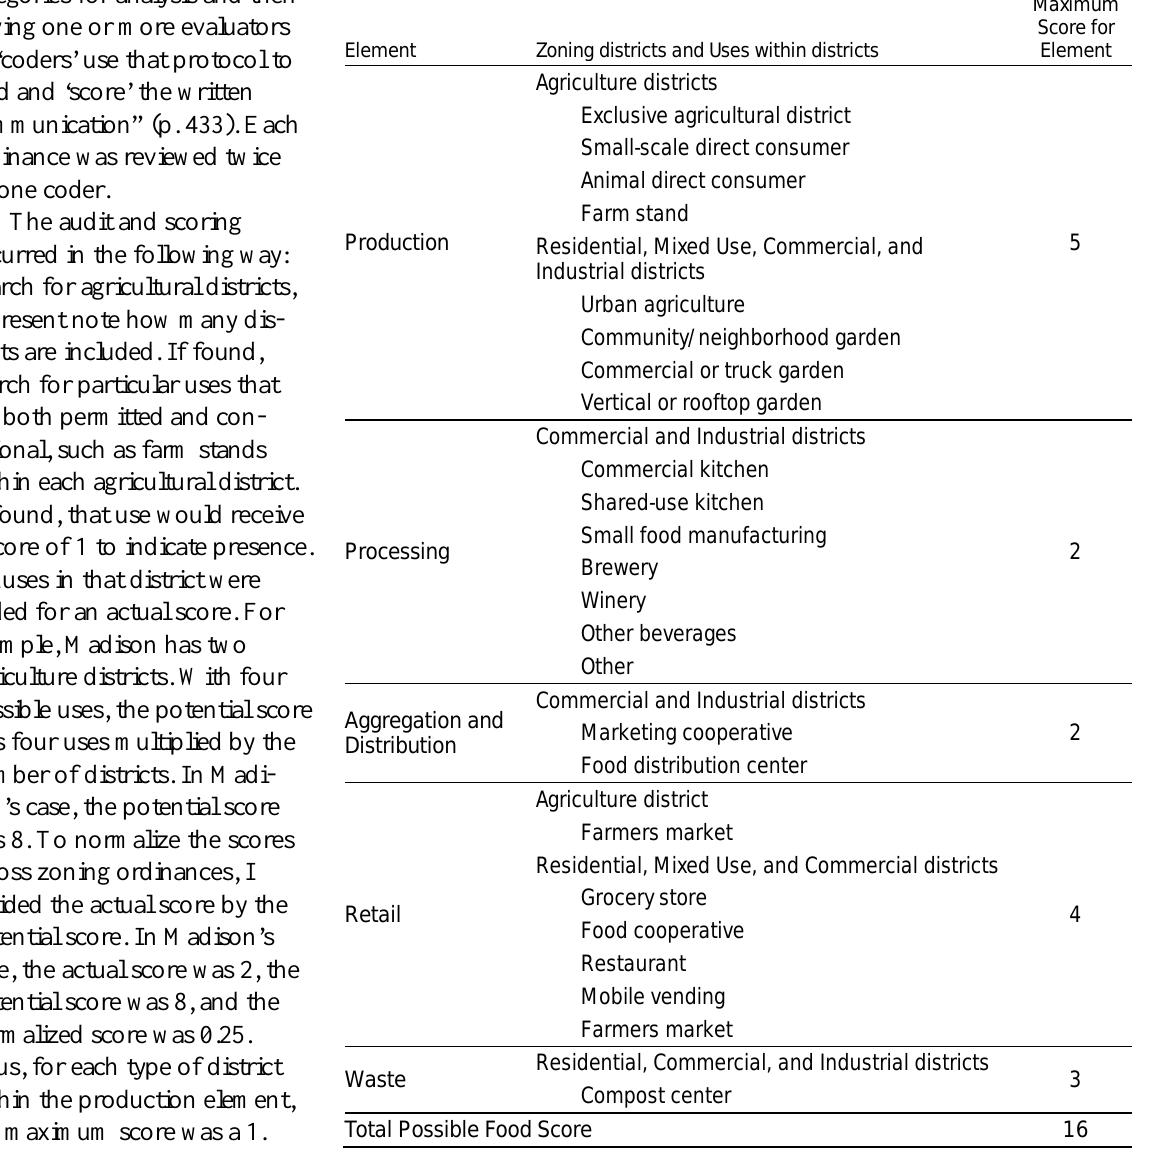
Table 2. Zoning Ordinance Audit